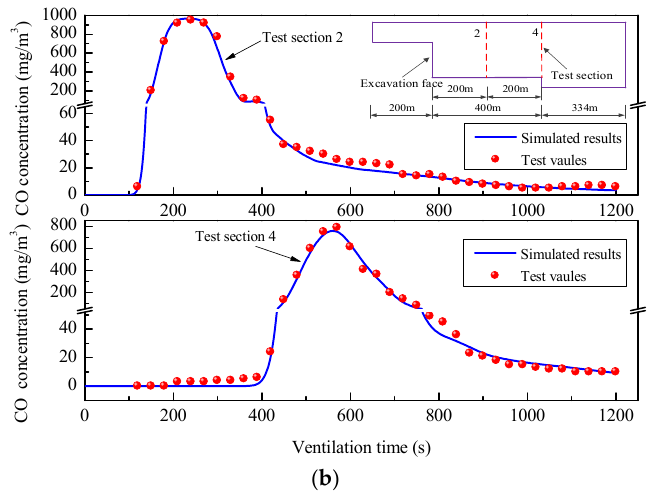
Figure 7. The comparison between the simulated result and field test: ( a ) Air velocity in the main cavern and construction roadway; and ( b ) The change of CO concentration with time.